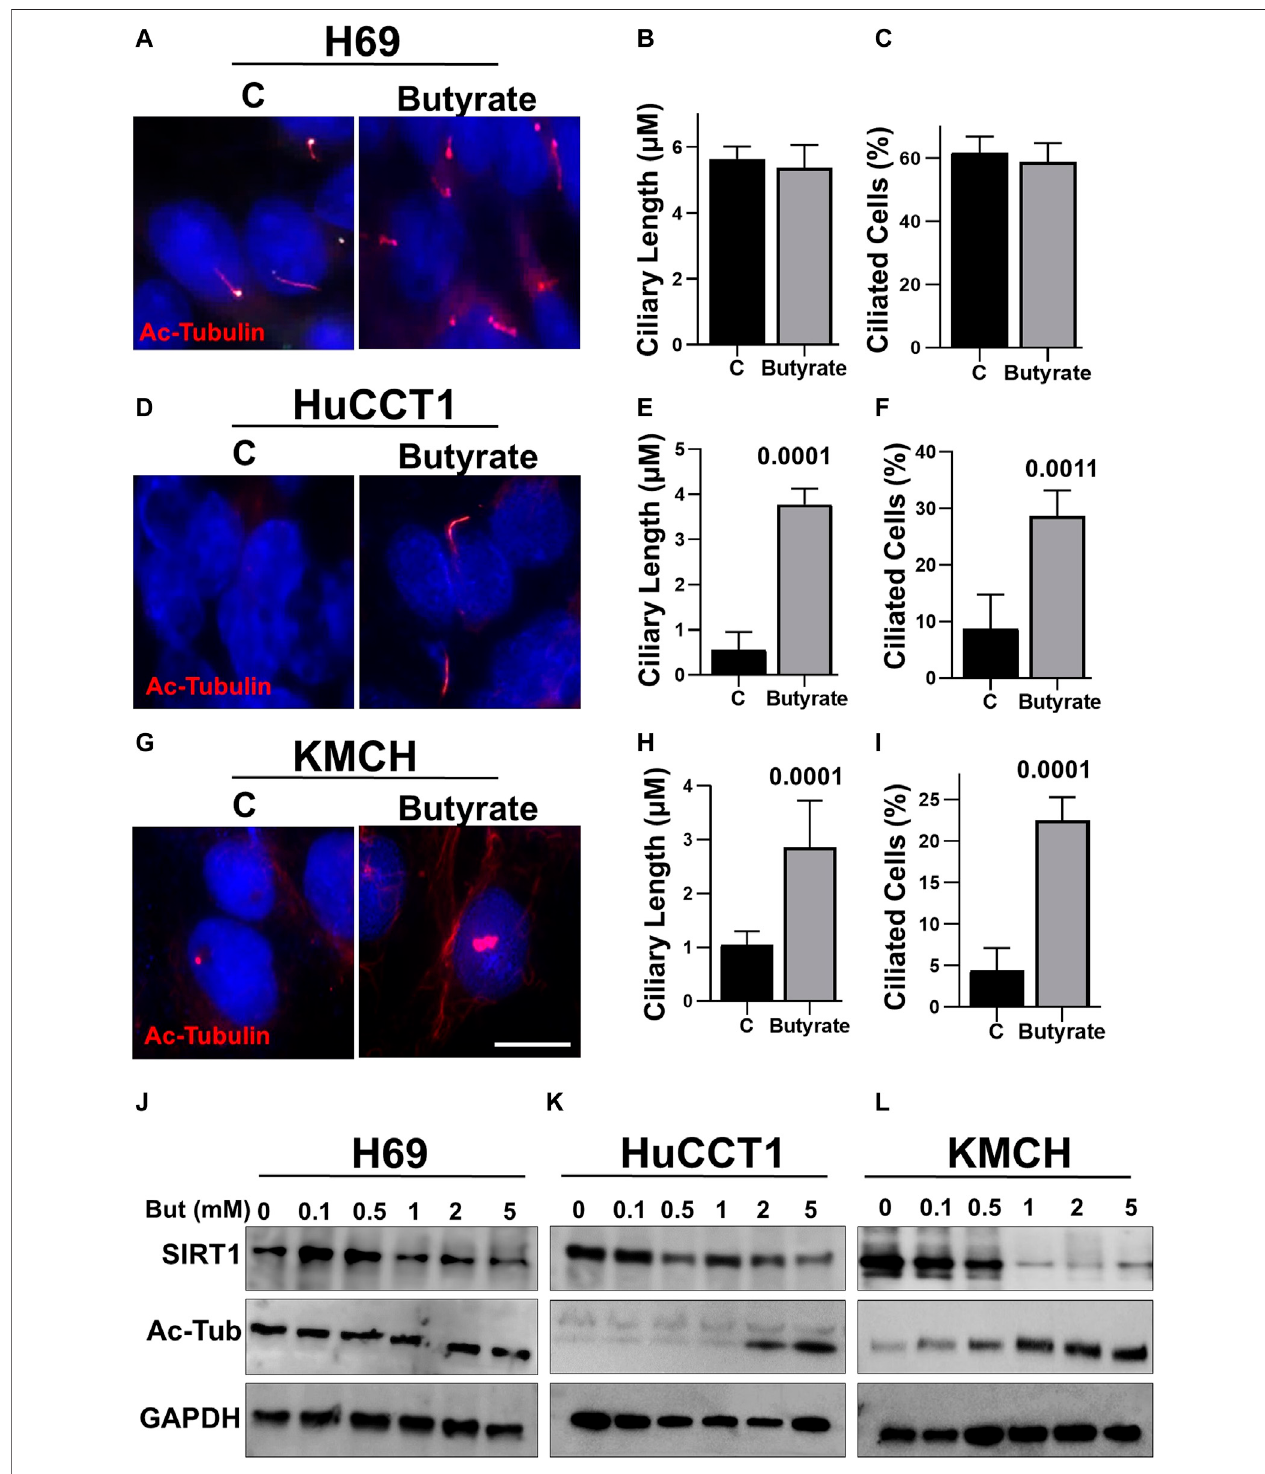
FIGURE1| ButyrateinducesciliaformationofCCAcells.BothHuCCT1andH69cellswereculturedfor24 handtreatedwithbutyrate(2 mM)orvehiclefor48 hin serum-freemedia.Thecellswere fi xedandstainedfortheAc-alpha-tubulinantibody. (A) TheH69cellswereobservedundermicroscope63xoilforciliaimages,andthe representative picture isshown. (B, C) The cilia length and frequency were calculated in H69 cells. (D) HuCCT1 cells were visualized under microscope for cilia imaging. (E, F) The cilia length and frequency were measured in HuCCT1 cells. (G) KMCH cells were visualized under microscope for cilia imaging with Ac-tubulin staining. (H,I) ThecilialengthandfrequencyweremeasuredinKMCHcells. (J) TheexpressionofSIRT1andAc-tubulinwascheckedinH69celltreatedwithbutyrate(0.1 – 5 mM) usingWesternblotting. (K,L) WesternblottingwasdonefortheSIRT1andAc-tubulininthepresenceofButyrateindifferentconcentrations(0.1 – 5 mM)inHuCCT1and KMCH cells. GAPDH was used was loading control.